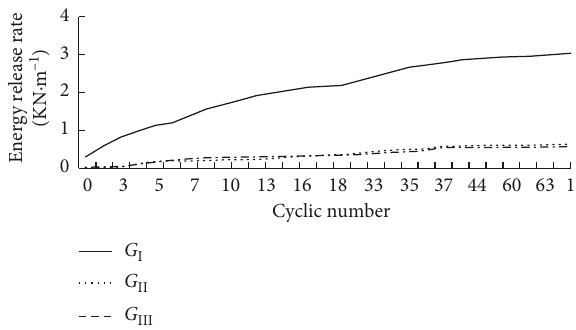
Figure 17: The cumulative strain energy release rate during the process of crack propagation at the welding toe of U-rib.